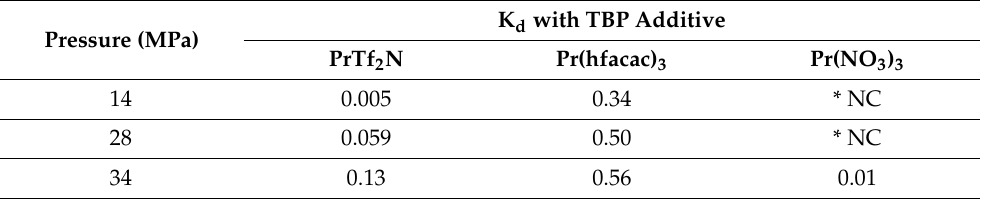
Table 4. Values of the Distribution Coefficient for the scCO 2 phase with the TBP additive at 308 K. K d with TBP Additive Pressure (MPa) PrTf 2